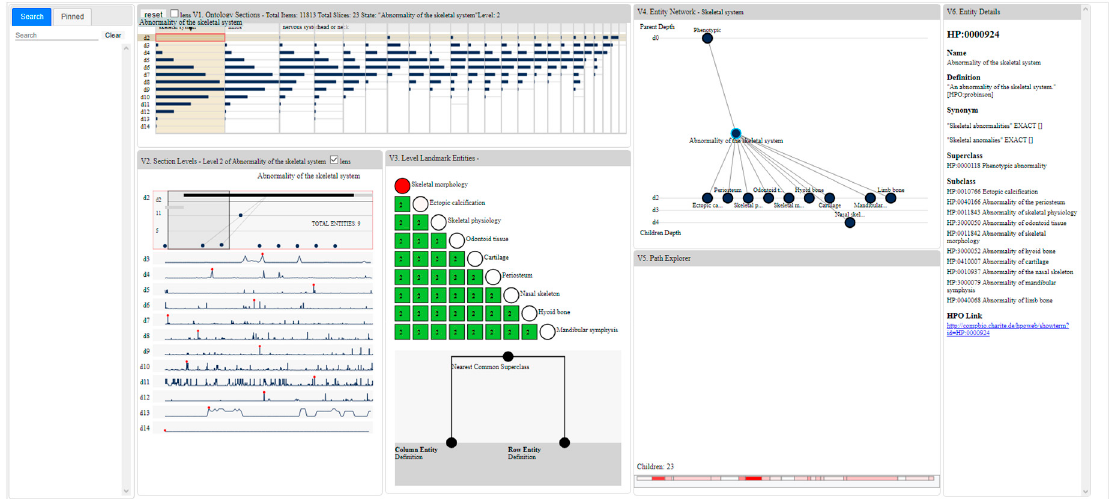
Figure 19. An overall view of the PRONTOVISE ontology visualization system in its initial state after the Human Phenotype Ontology has been uploaded.